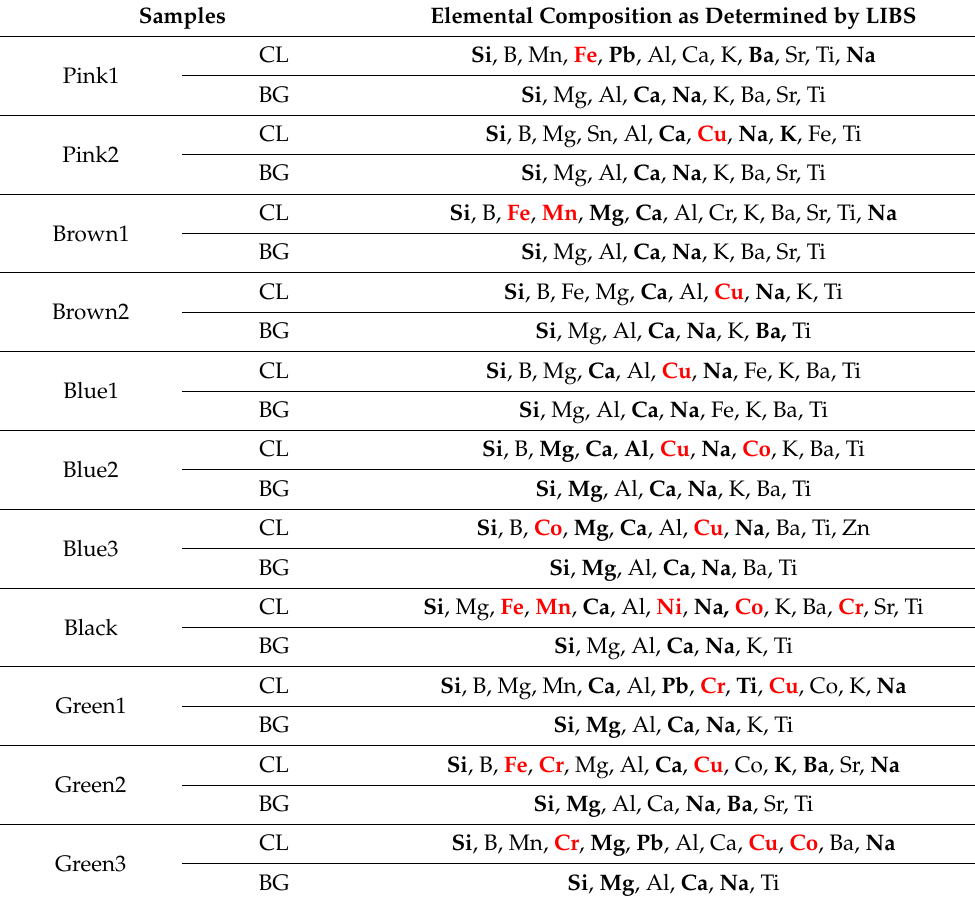
Table 3. Elemental composition of base glass and colored layers of flashed glasses as determined by LIBS. The main components and possible chromophores are indicated in bold black and bold red, respectively. BS: Base glass, CL: Colored